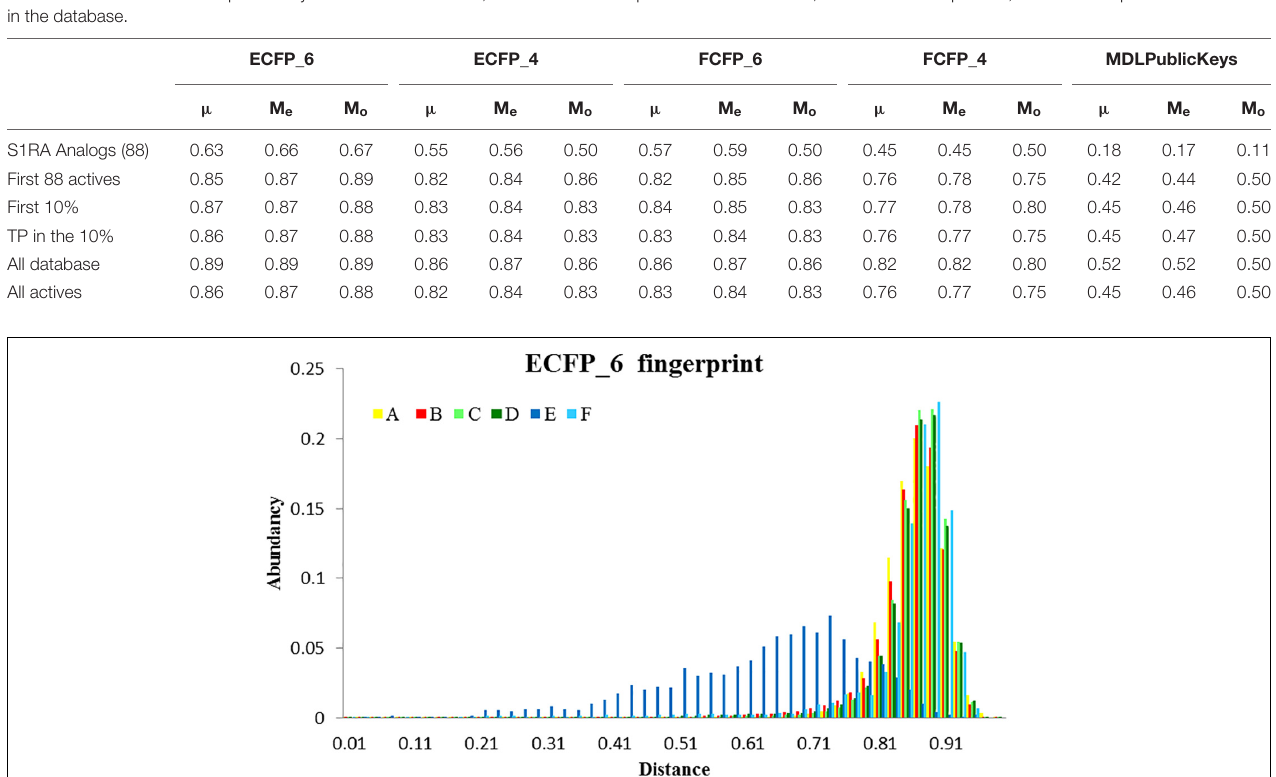
FIGURE 11 | Analysis of the diversity of the compounds with σ 1R affinity compared to the diversity of the whole database and compared as well with the diversity shown by the analogs of a lead compound. The diversity obtained by the pharmacophore selection (C) is comparable to that of the whole database (A). A, All library compounds; B, Active compounds in the library; C, first 10% of selected compounds by the 5HK1–Ph.B model; D, True positives within this 10%; E, 88 analogs of S1RA (E52862); F, First 88 ranked compounds by the 5HK1–Ph.B model.